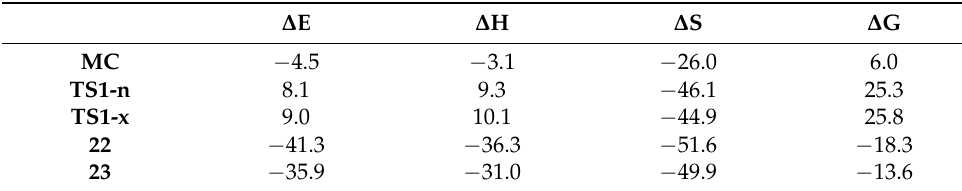
Table 3. ω B97XD/6-311G(d,p) relative electronic energies ( Δ E, in kcal·mol − 1 ), enthalpies ( Δ H, in